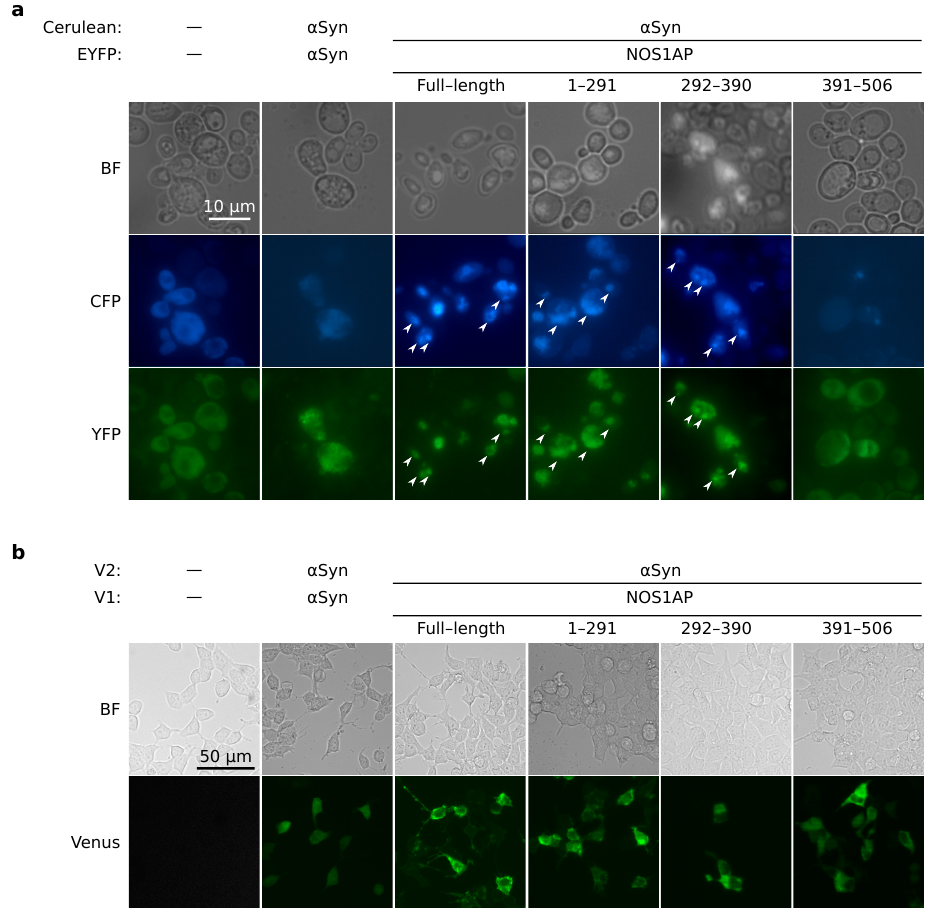
Figure 5. NOS1AP interacts with α -synuclein in yeast and mammalian cells. ( a ). Microphotographs of yeast cells overproducing EYFP-NOS1AP (full-length or truncated) and Cerulean- α Syn. Arrowheads mark examples of co-localisation of bright foci formed by different proteins. ( b ) Microphotographs of HEK293T cells overproducing proteins of interest fused with N- and C-terminal fragments of Venus protein, designated V1 and V2,